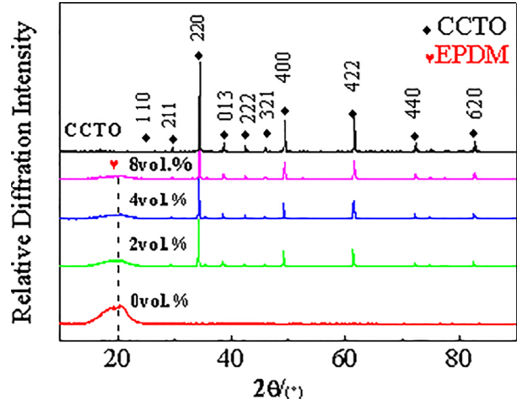
Figure 2. X-ray diffraction patterns of CaCu 3 Ti 4 O 12 (CCTO) particles and CaCu 3 Ti 4 O 12 / Ethylene Propylene Diene Monomer (CCTO/EPDM) composites.